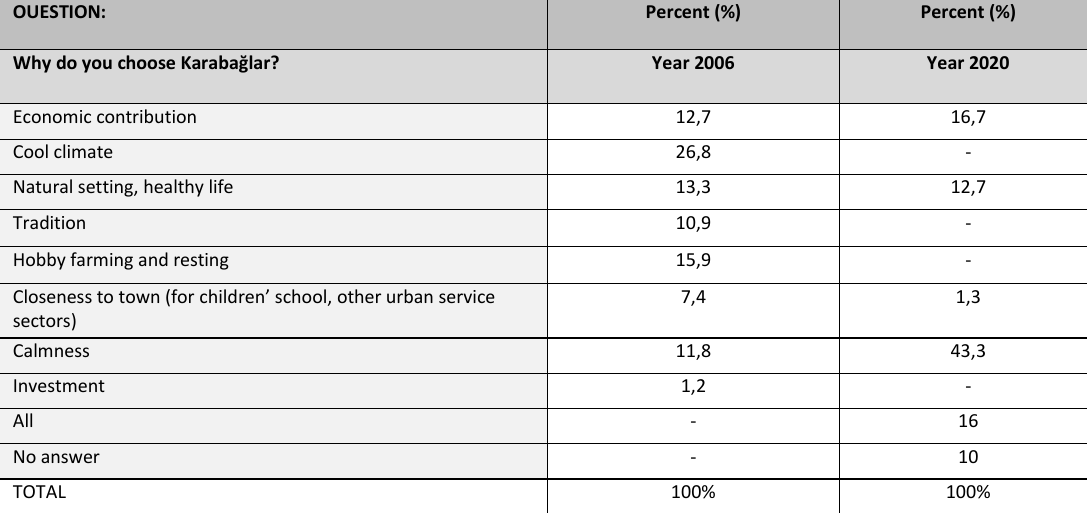
Table 2 Answers to the question: Why do you choose